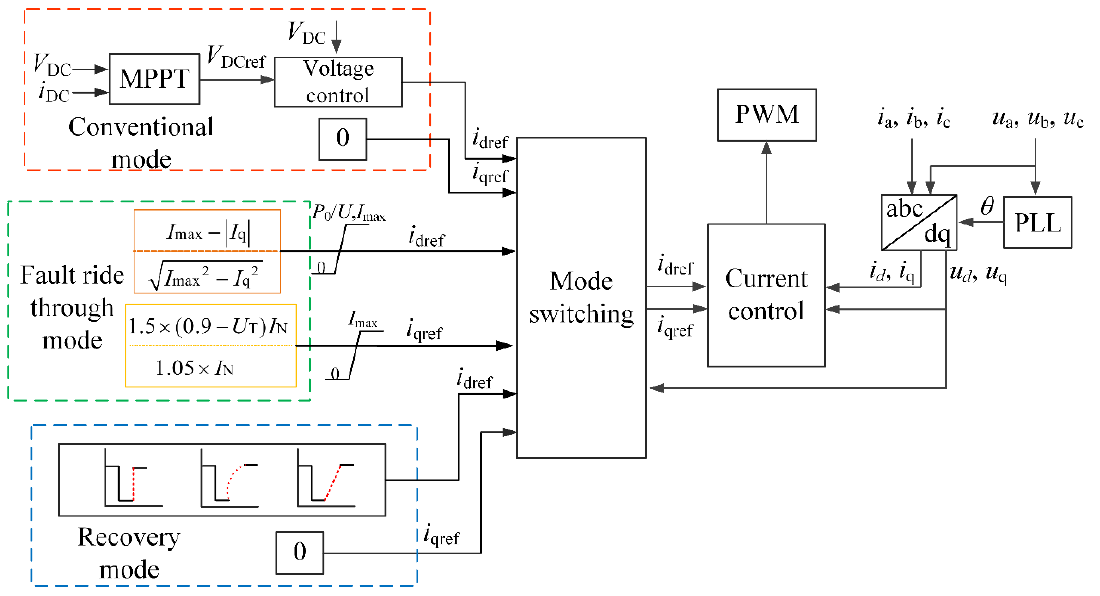
Figure 3. Control block diagram of PV inverter considering LVRT capability.